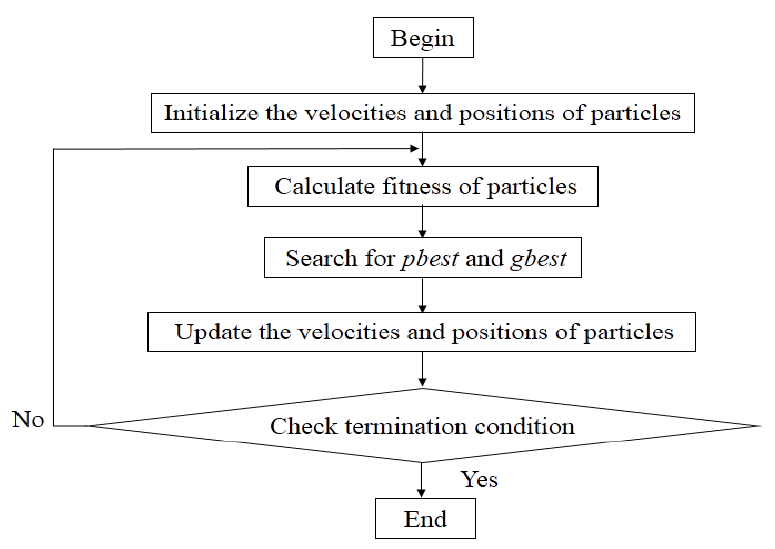
Figure 2. Flow chart of particle swarm optimization (PSO) algorithm. The steps involved in PSO are as